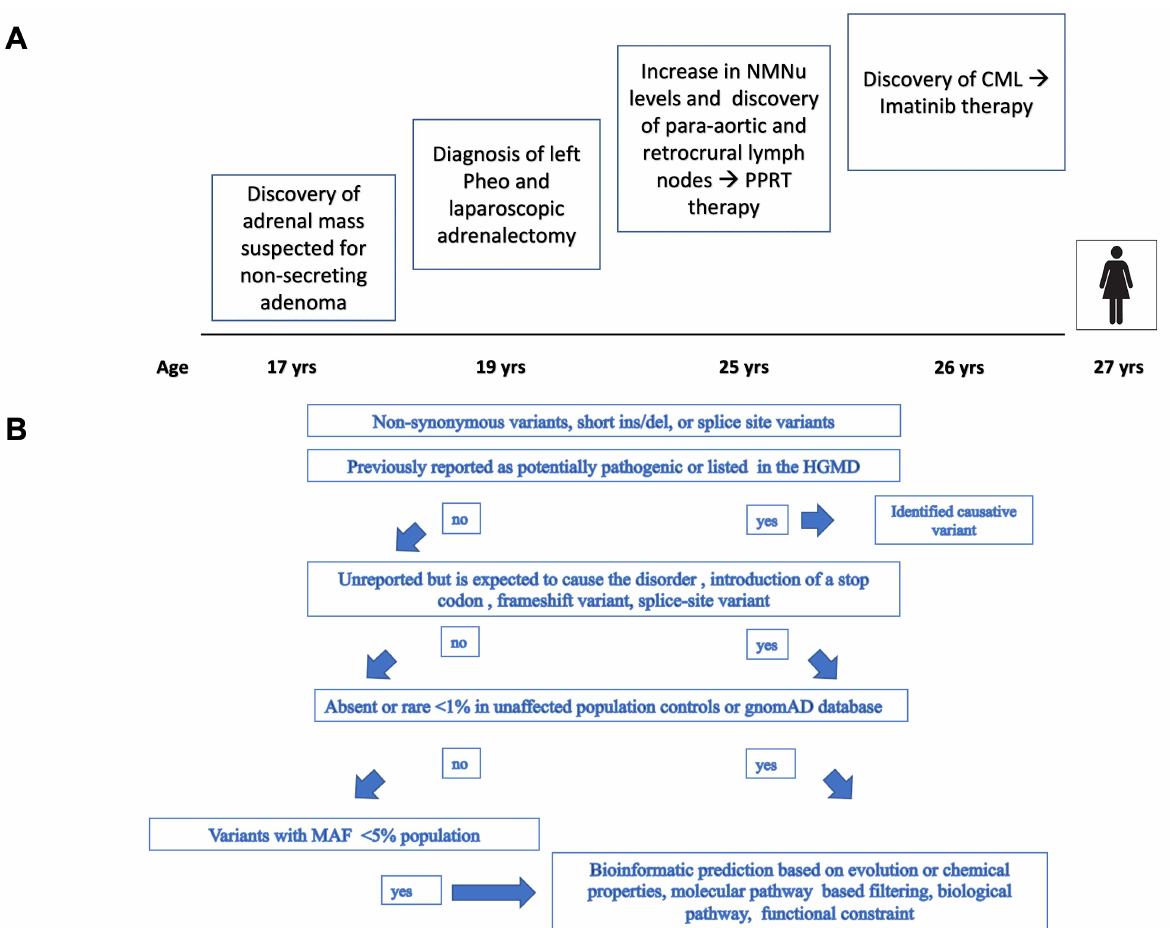
Figure 1. ( A ): Timeline of clinical presentation of the present case. ( B ): Flow chart illustrating the filtering process and variant selection used to identify pathogenic variants.